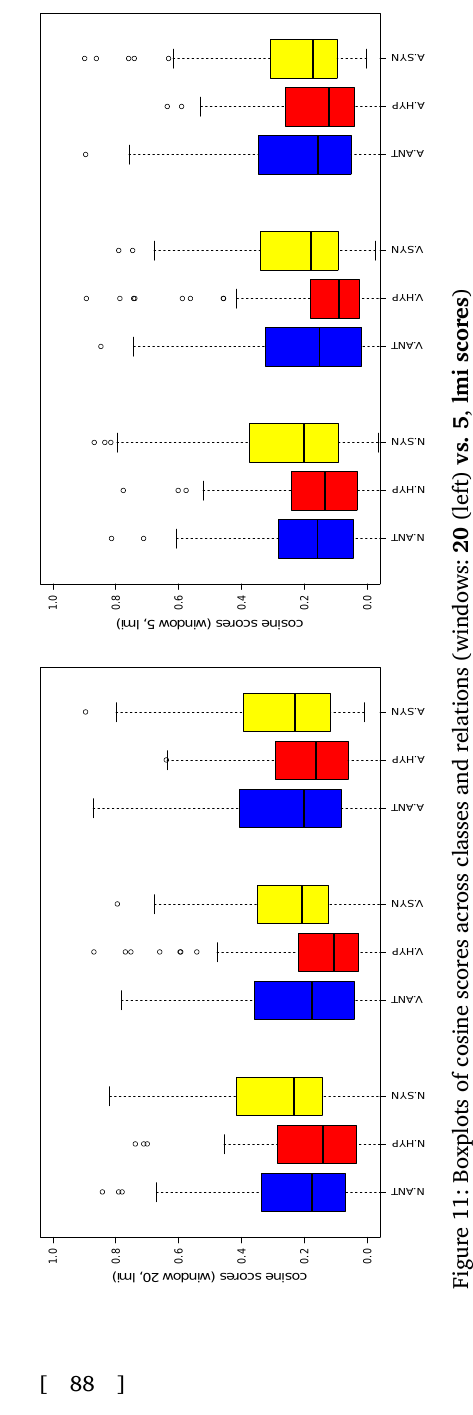
cosine scores (window 5,